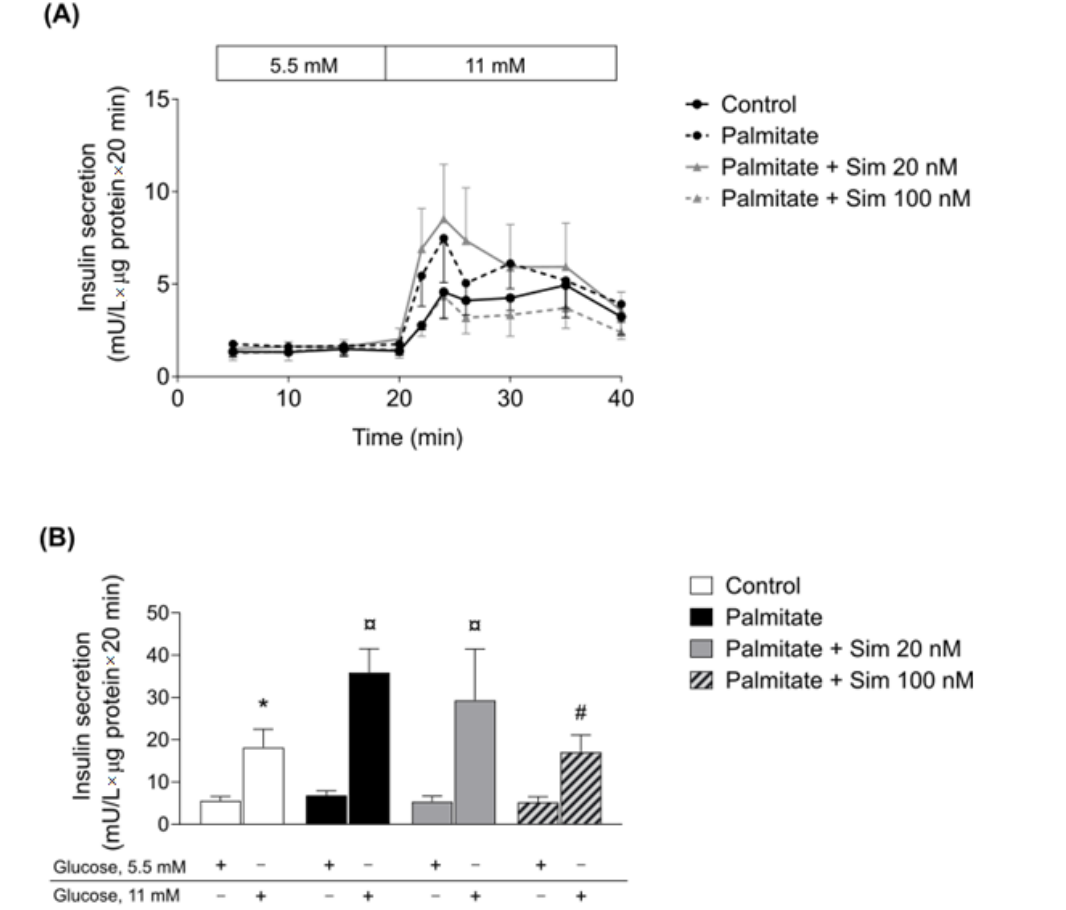
Figure 4. ( A ) Glucose-stimulated insulin secretion from perifused human islets exposed to palmitate (black dashed line), the combination palmitate and simvastatin 20 nM (grey line), the combination palmitate and simvastatin 100 nM (grey dashed line) or in the absence of compounds, control, (black line) for 48 h. Insulin secretion was measured at 5.5 and 11 mmol/L glucose, 20 min each, and normalized to protein. ( B ) AUC insulin secretion for 5.5 and 11 mmol/L glucose was calculated from panel A. Data are shown as mean ± SEM for 4 independent experiments (with 4 different human islet preparations). * p < 0.05 compared to control 5.5 mM, ¤ p < 0.05 compared to control 11 mM, and # p < 0.05 compared to palmitate 11 mM alone (black bar).